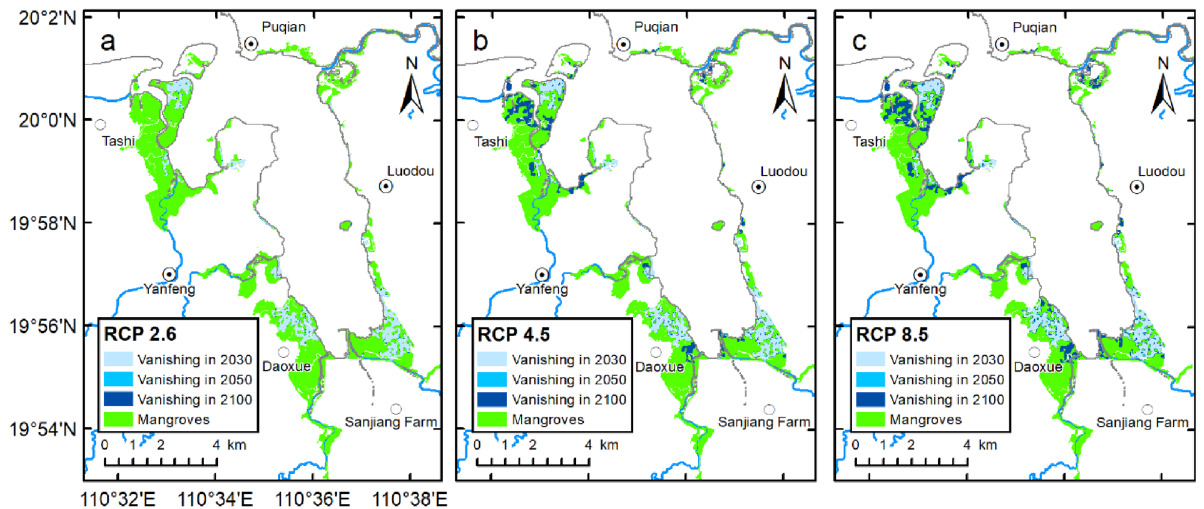
Figure 6. Potential loss of mangrove forests in Dongzhaigang under different climate scenarios (RCPs 2.6, 4.5, and 8.5). Maps generated in ArcMap v10.0 (https:// www. esri. com/ en- us/